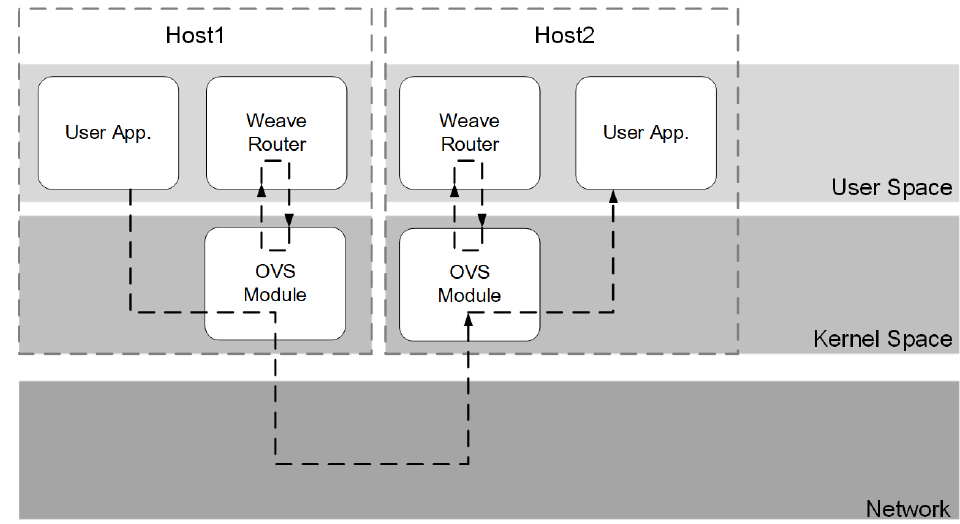
Figure 10. Overview of Weave.